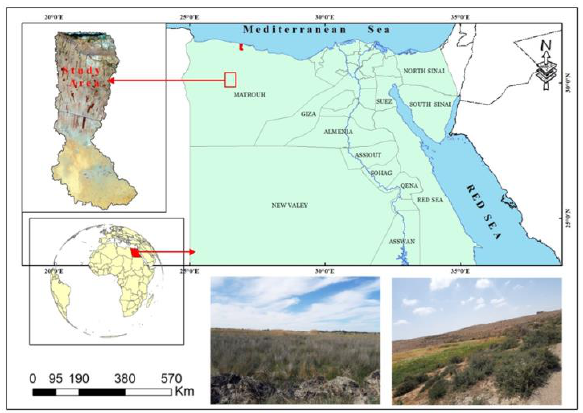
Figure 2. Location of the investigated area .